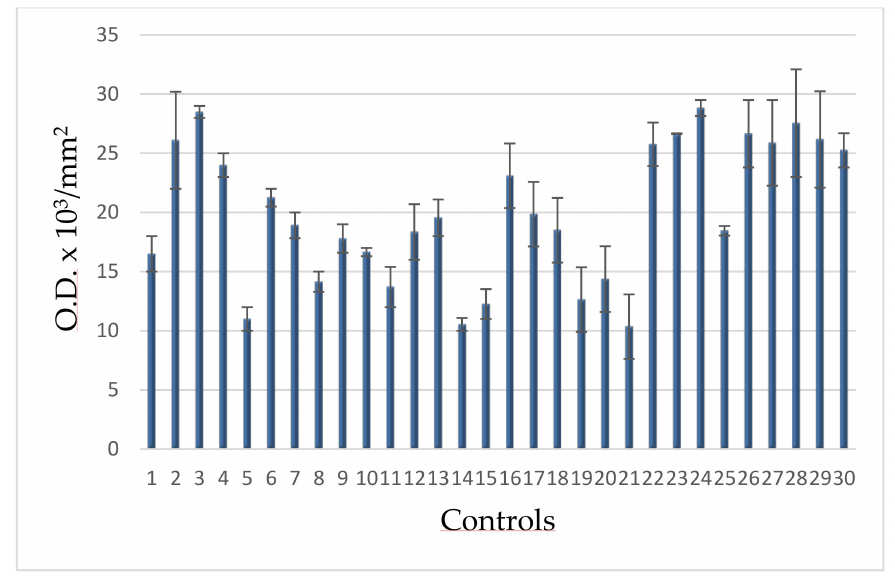
Figure 5. PAR-PARP levels of blood donors.